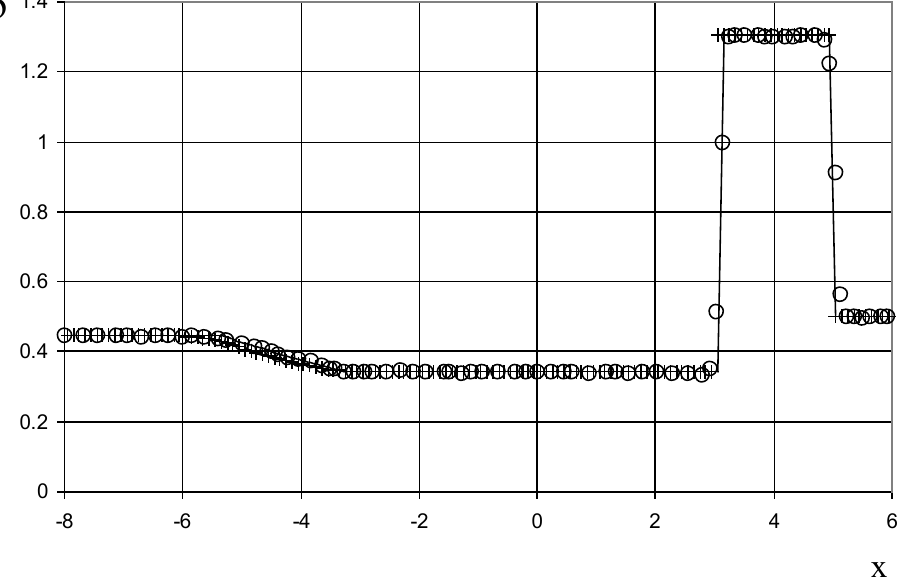
Figure 15. Velocity plot for the Riemann problem of Lax: the exact solution (line), the ULT1C scheme of Harten (circle), and the present method (cross).